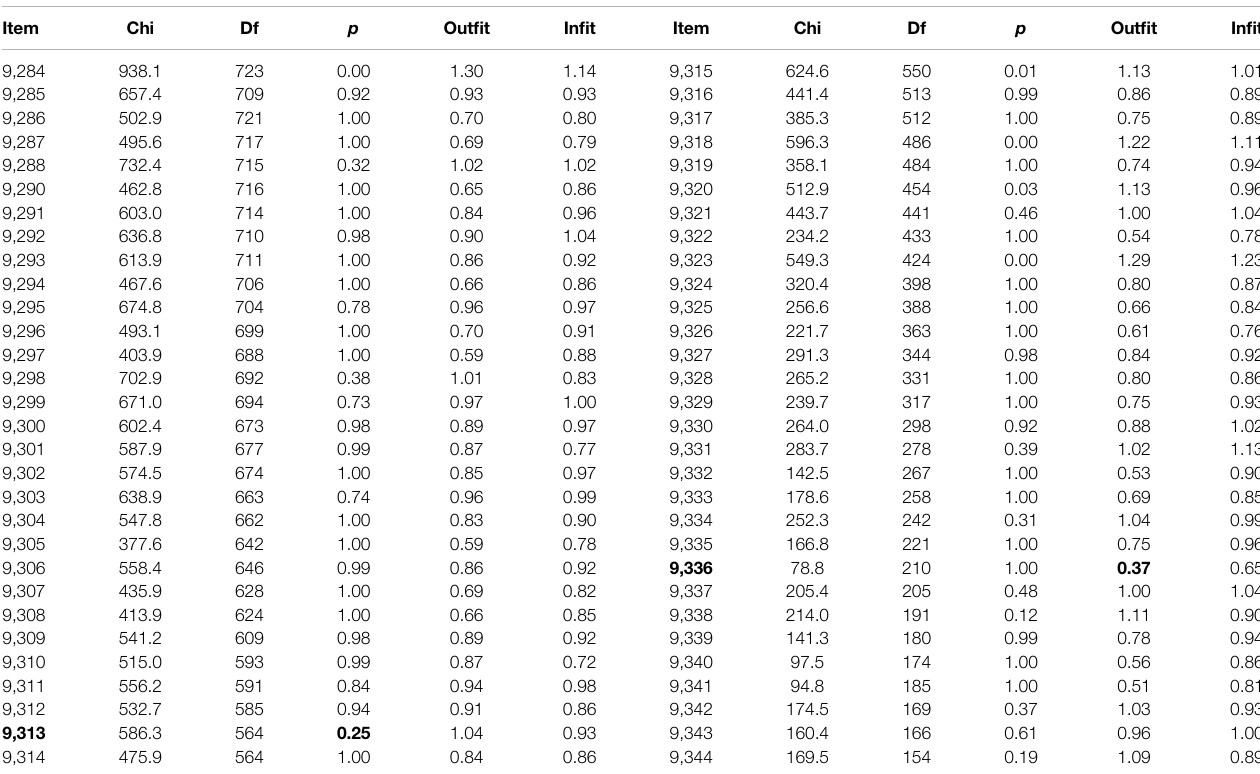
TABLE 2 | In fi t and Out fi t Statistics of the Items (t1; with missingness).